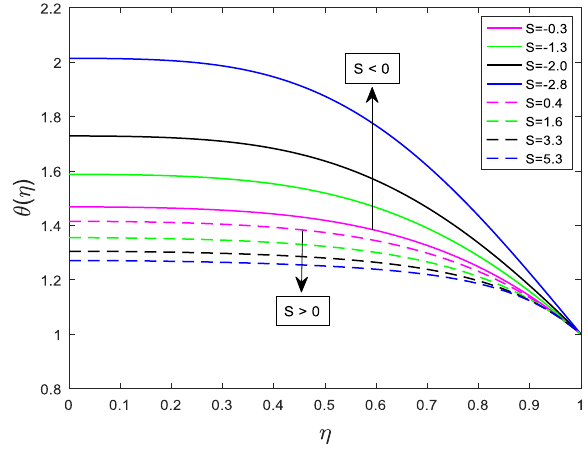
Figure 2: Effect of S on F ( η ) for fixed β = 2.2, Ha = Ω T = N t = 0.1, Ω = Ec = 0.5, Pr = Sc = 0.7, and Kr = N C